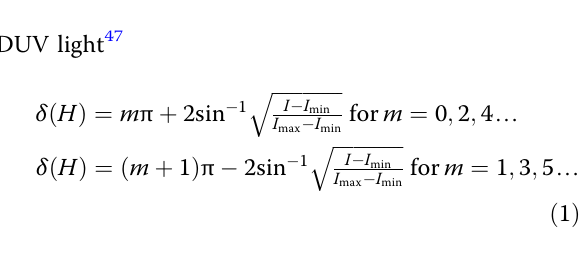
Fig. 2 Performance of 2D CTO DUV modulator. a Reversibility test of transmitted DUV intensity. Insets: fi eld-intensity correspondence at an interval of 0.1 T from − 0.8 T to 0.8 T. b Transient magneto-optical signal of transmitted DUV light (upper panel) in response to a magnetic pulse with a peak strength of 1.3 T (lower panel). c Cycling test about stability of 2D CTO LC modulator: time-dependent intensity of transmitted DUV light (upper panel) as the magnetic fi eld of ±0.8 T is periodically turned on and off per 10 s (lower panel). d Fatigue test of transmitted intensity versus exposure time under continuous DUV irradiation for 300 min. Magnetic fi eld of 0.8 T is kept in turn-on status. DUV light intensity: 200 mW cm −